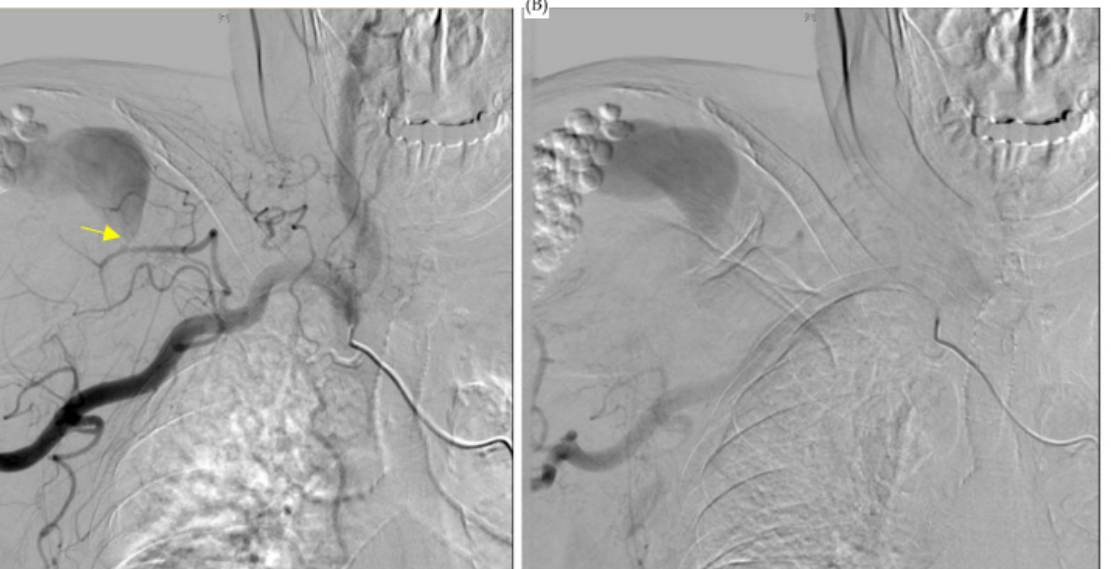
Figure 3. Angiogram showed a pseudoaneurysm. ( A ) Angiogram showed that the feeding artery of the pseudoaneurysm was the thoracoacromial artery, acromial branch (arrow). Antibiotic beads were noted in this angiogram (arrowhead). ( B ) The aneurysm extended to acromion of scapula.